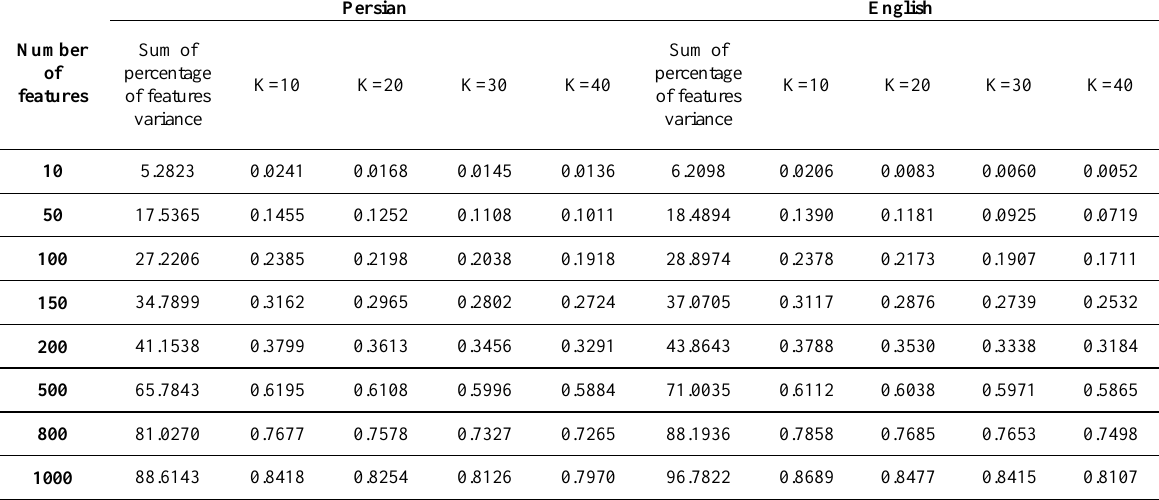
Table 1. Comparing Persian and English clusters with equal vectors dimensions for several Ks. Number of features